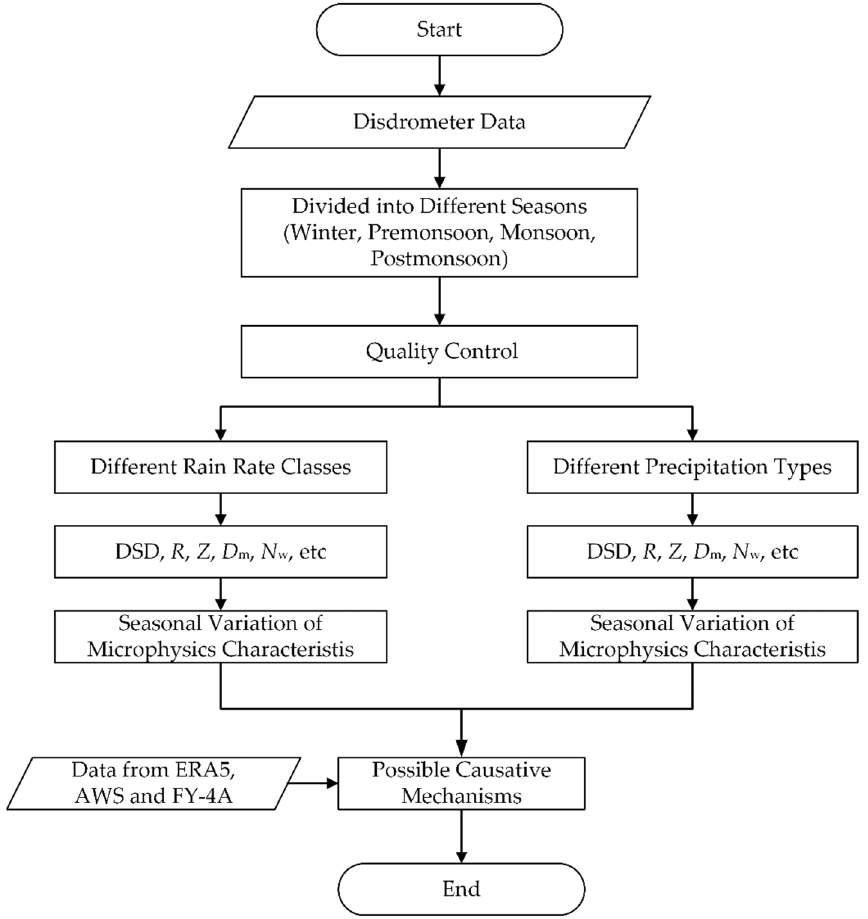
Figure 1. Methodological workflow diagram adopted in this study.